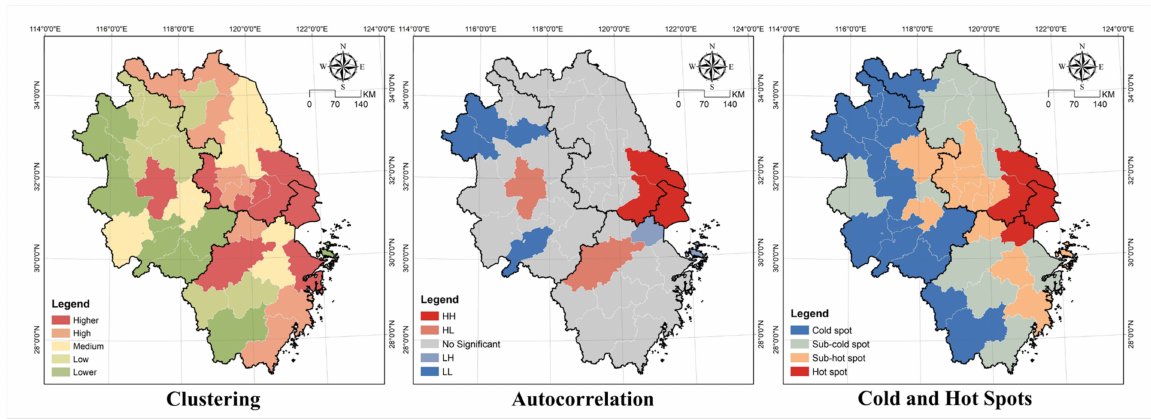
Figure 4. Spatial analysis of the relative share in 2010–2014.